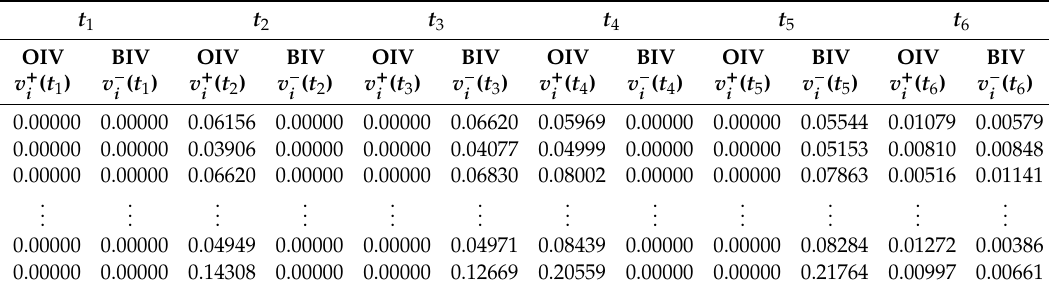
Table 10. Optimal and negative incentive control module value.